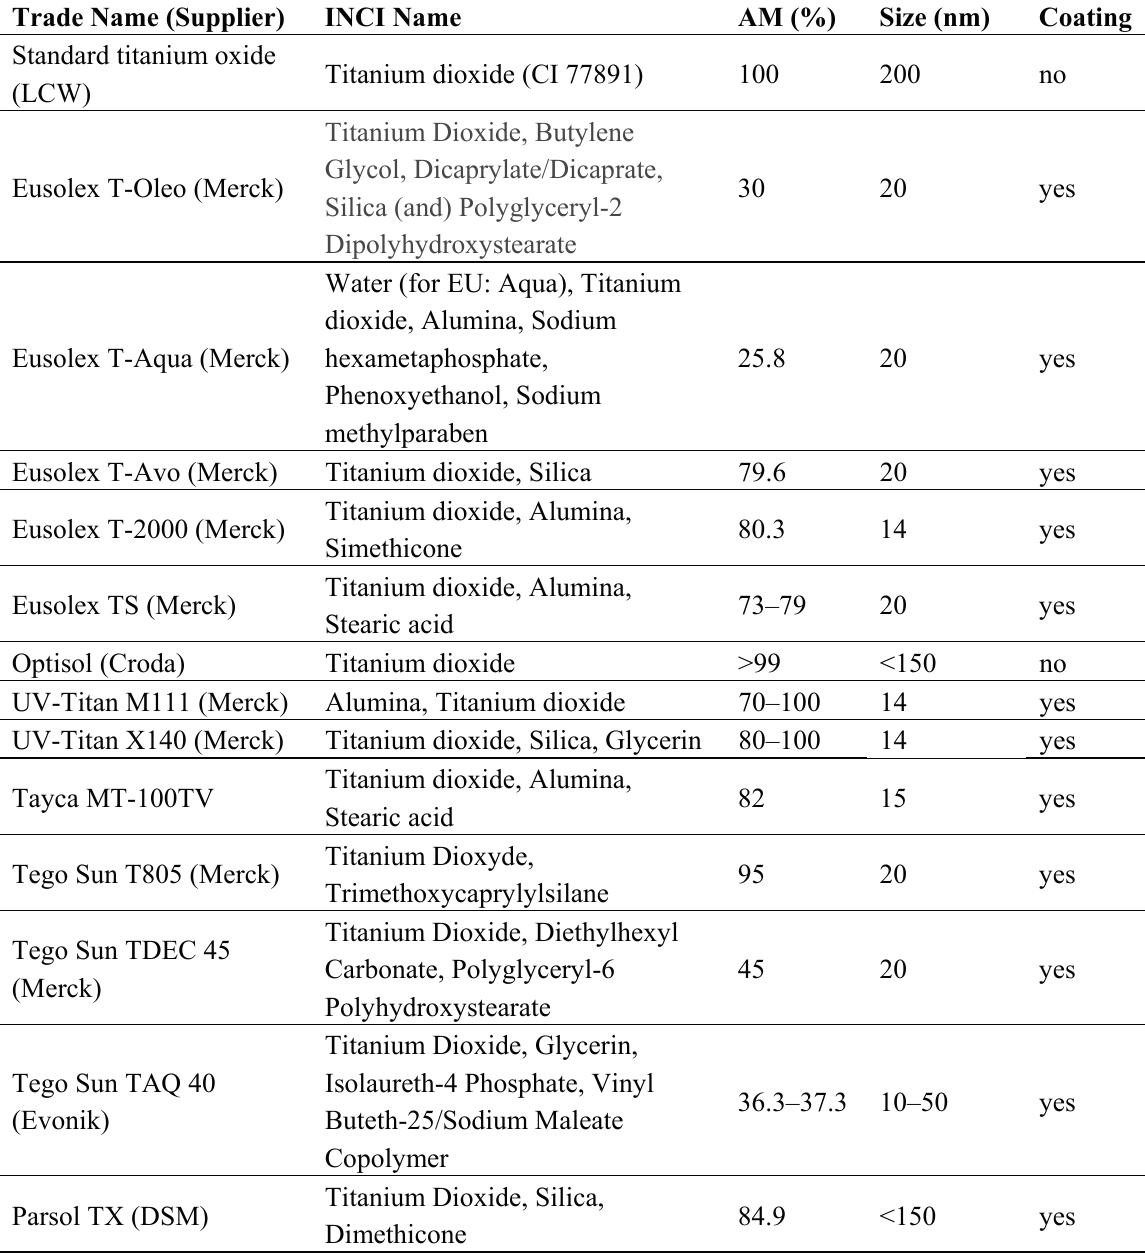
Table 3. Example of commercial forms of titanium